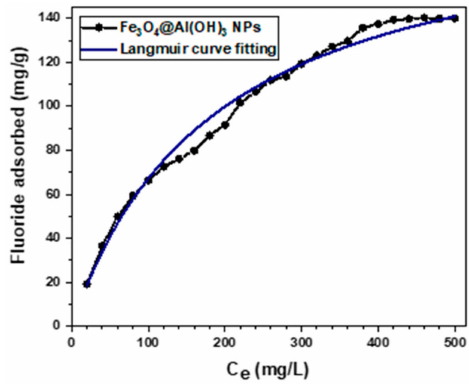
Figure 7. Equilibrium isotherm of fluoride adsorption by Fe 3 O 4 @Al(OH) 3 NPs at 25 ◦ C, pH 6.5.